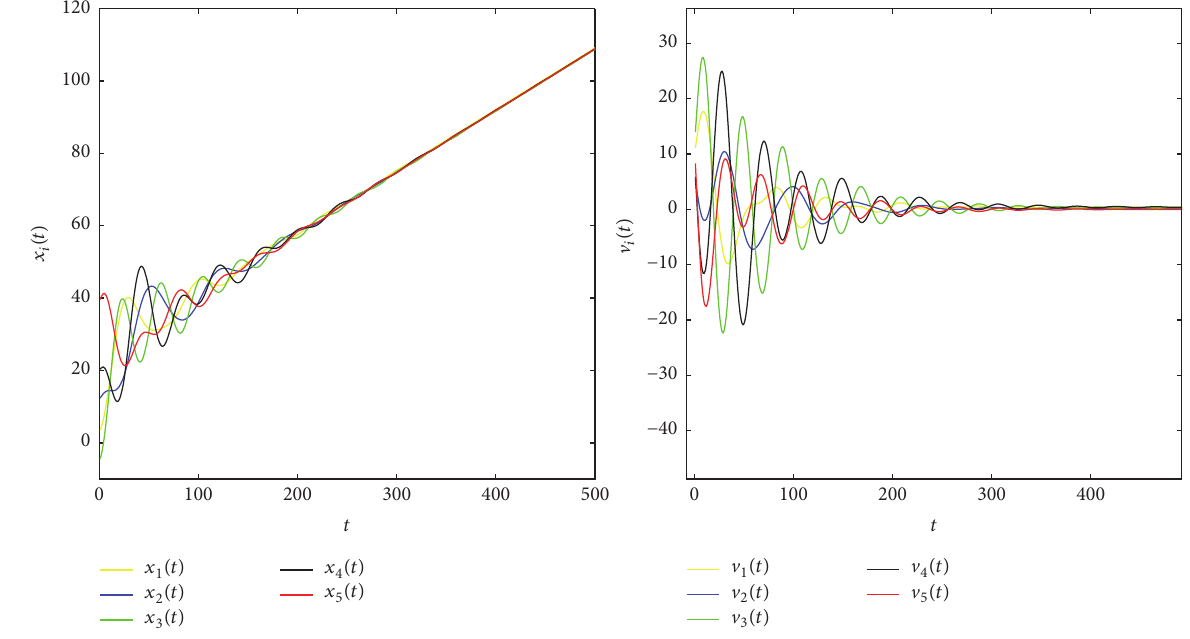
Figure 4: 𝑥 𝑖 (𝑡) and V 𝑖 (𝑡) of each agent with protocol (7), 𝛼 = 1.3 .